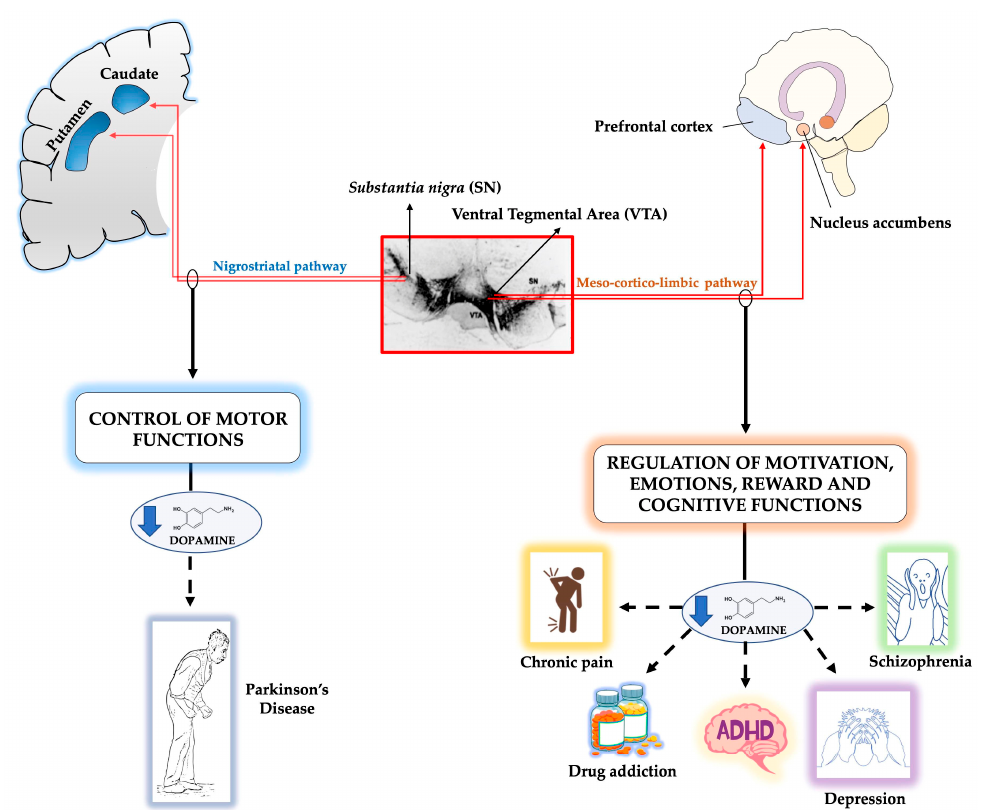
Figure 1. Schematic representation of the midbrain dopaminergic pathways. The figure illustrates in a schematic representation the two dopaminergic pathways originating from the midbrain (delimited by a red rectangle). The ventral tegmental area (VTA) and the substantia nigra (SN) in the adult ventral midbrain are visualized by anti-tyrosine hydroxylase antibodies. On the left: the nigrostriatal pathway connects the SN pars compacta in the midbrain with the dorsal striatum (i.e., caudate nucleus and putamen) in the forebrain. The main function of the nigrostriatal pathway is to control voluntary movement through basal ganglia motor loops. Degeneration of SN dopaminergic neurons leads to diminished concentrations of dopamine in the caudate-putamen. Degeneration of this pathway causes Parkinson’s disease (see text). On the right: the meso-cortico-limbic system pathway connects the VTA in the midbrain to the ventral striatum (i.e., nucleus accumbens) and to the prefrontal cortex. It regulates motivation, emotions, reward and cognitive functions. Dysfunction of this pathway is associated to schizophrenia, drug addiction, attention deficit hyperactive disorder (ADHD), depression and chronic pain (see text).